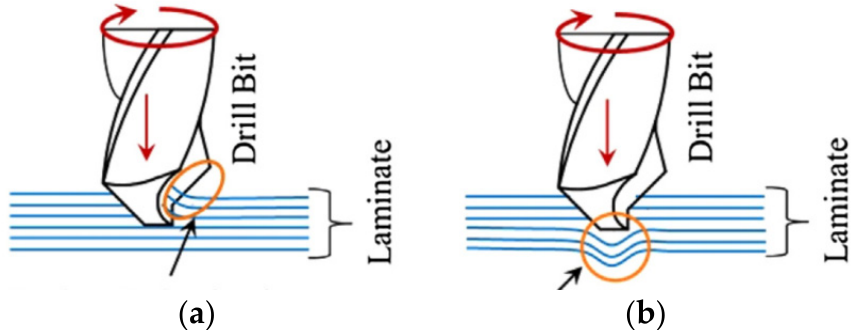
Figure 14. ( a ) peel-up and ( b ) push-down delamination of composite laminates (Reprinted with permission from Ref. [146], 2016, copyright The Society of Manufacturing Engineers. Published by Elsevier Ltd.).